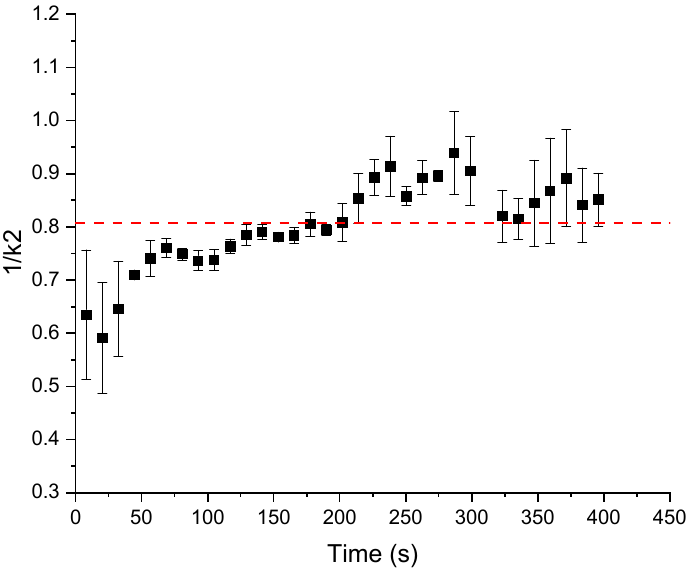
Figure 6. Parameter 1/k 2 calculated from normalizing the shear stress curves of the shear kneading process of standard wheat flour and water. Means are shown with standard deviation (n = 3).